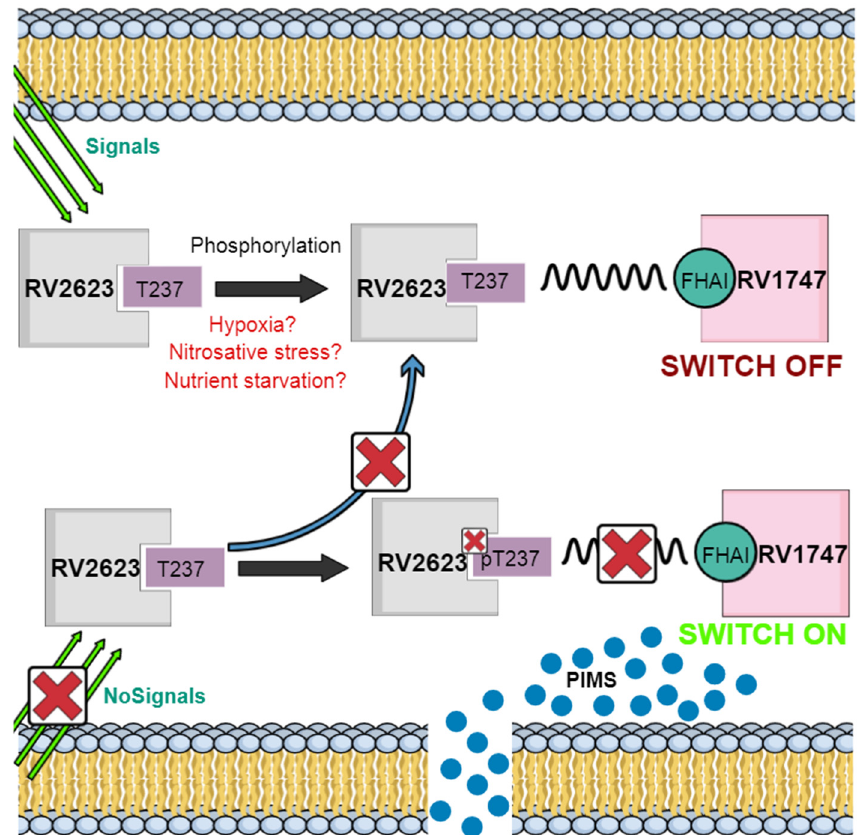
Figure 4. Mtb growth regulation by Rv2623. Phosphorylation of Thr237 results in Rv2623 interacting with the FHA I domain of Rv1747 in the presence of certain signals. Without these signals, the interaction between the Rv1747 FHA I domain and Rv2623 is broken due to dephosphorylation, resulting in Rv1747 being “switched off” and thus being able to transport PIMS. Suggestions have pointed toward hypoxia, nitrosative stress and nutrient starvation as possible triggers of Rv2623 phosphorylation, but this remains unconfirmed.